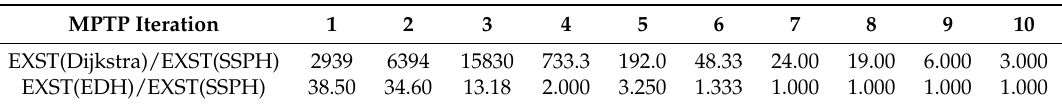
Table 16. Ratio between explored states for Dijkstra vs. A* with SSPH and A* with EDH vs. A* with SSPH , if the aircraft can only turn